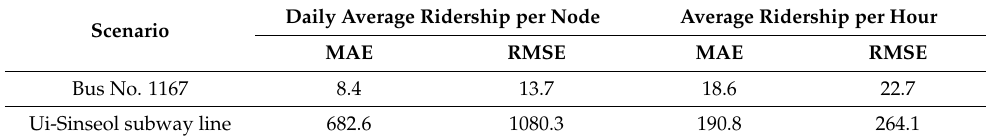
Table 2. Prediction errors of two